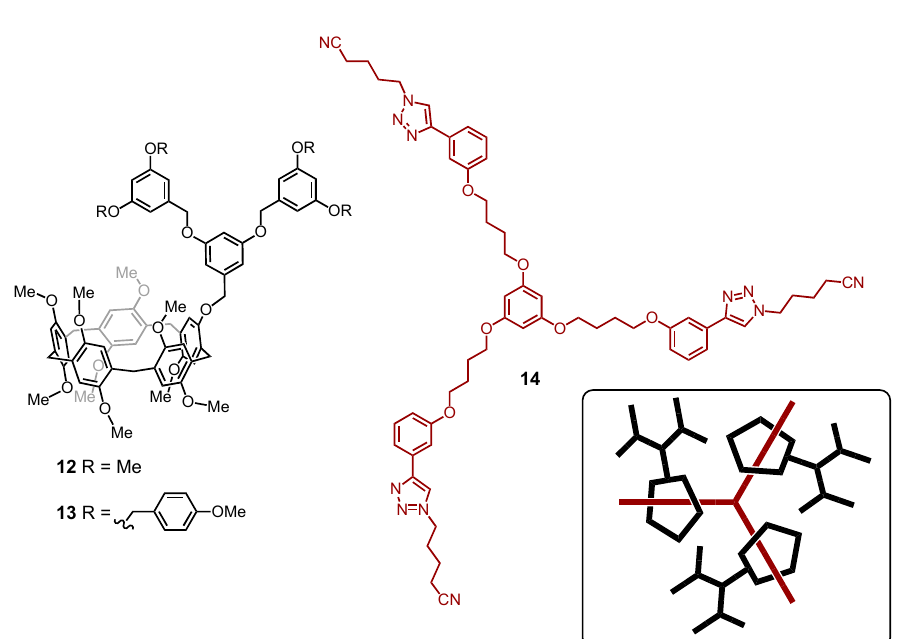
Figure 9. Dendronized pillar[5]arene derivatives 12 and 13 , and tritopic ligand 14 . The inset shows a schematic representation of the self-assembled dendrimer resulting from the binding of 14 with three pillar[5]arenes 13 (MW: 1159.34 ( 12 ); 1463.73 ( 13 )).